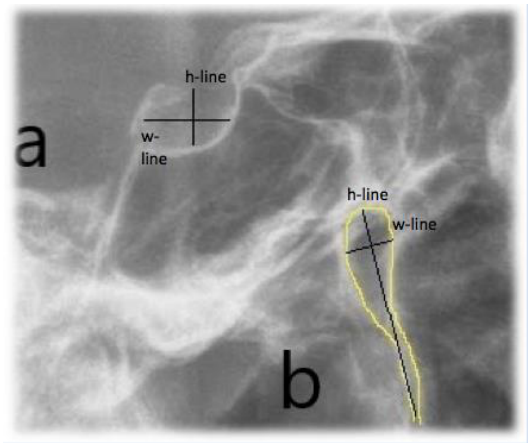
Figure 4. Sella Turcica (a) and pterygopalatine fissure morphology analysis (b). Reference lines: h-line (height/depth) and w-line (width/length).